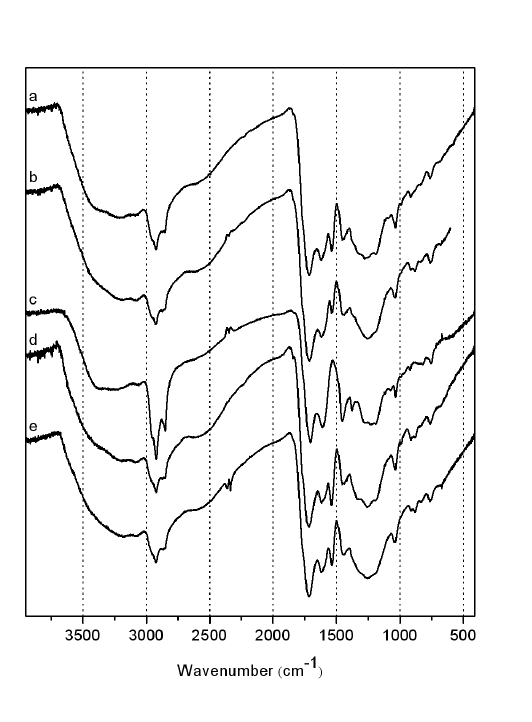
Fig. 8 FTIR spectra of CH 2 Cl 2 extracts: (a) dpf, (b) O 2 /125, (c) O 2 /Na 2 CO 3 , (d) 5% HNO 3 , (e)